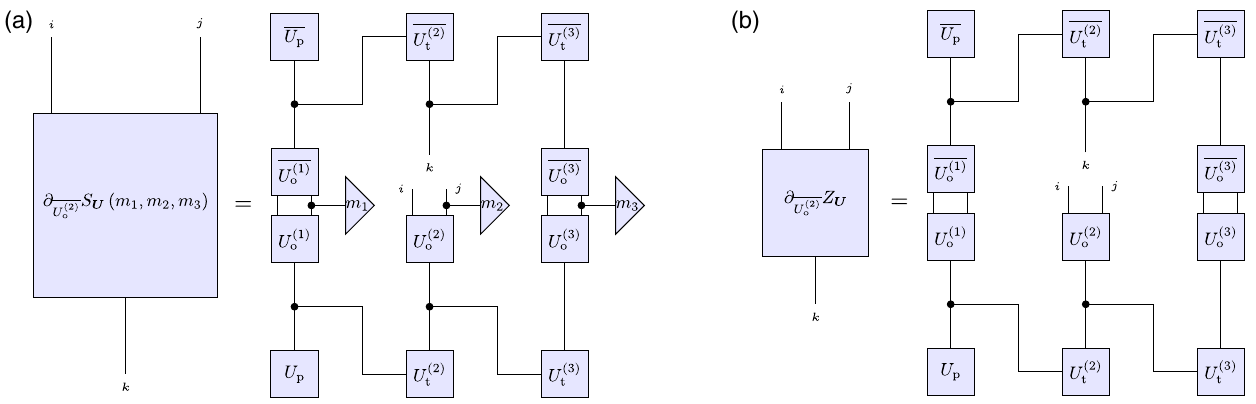
2 Þ m Þ with respect to U ð FIG. 12. (a) Derivative of S o , using the network given in Fig. 6(b) as an illustrative example. (b) Derivative of U ð 2 Þ Z with respect to U ð o , using the network given in Fig. 6(b) as an illustrative example. U